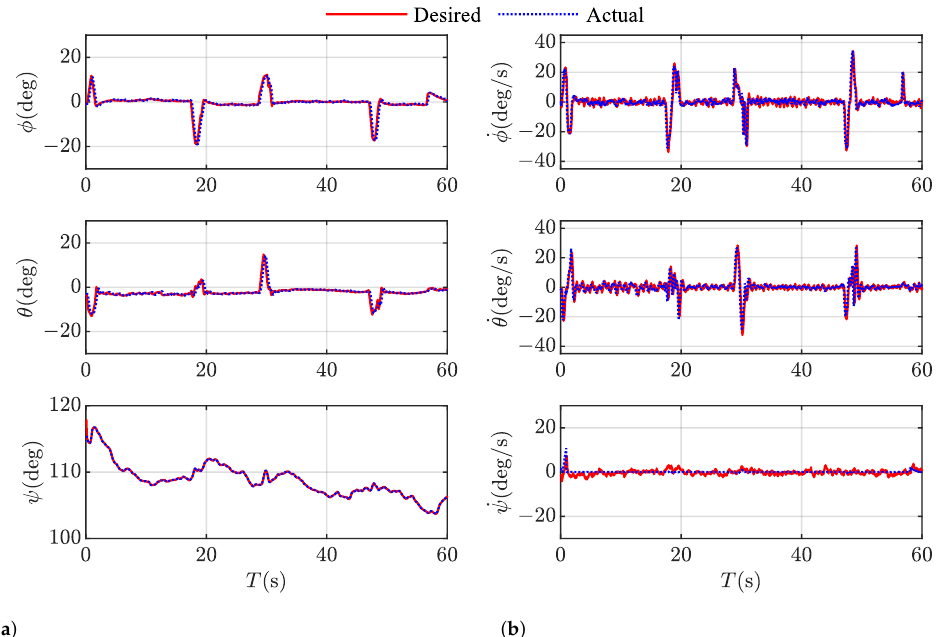
Figure 17. Attitude tracking during flight: ( a ) attitude angle tracking response; ( b ) attitude angle velocity tracking response.